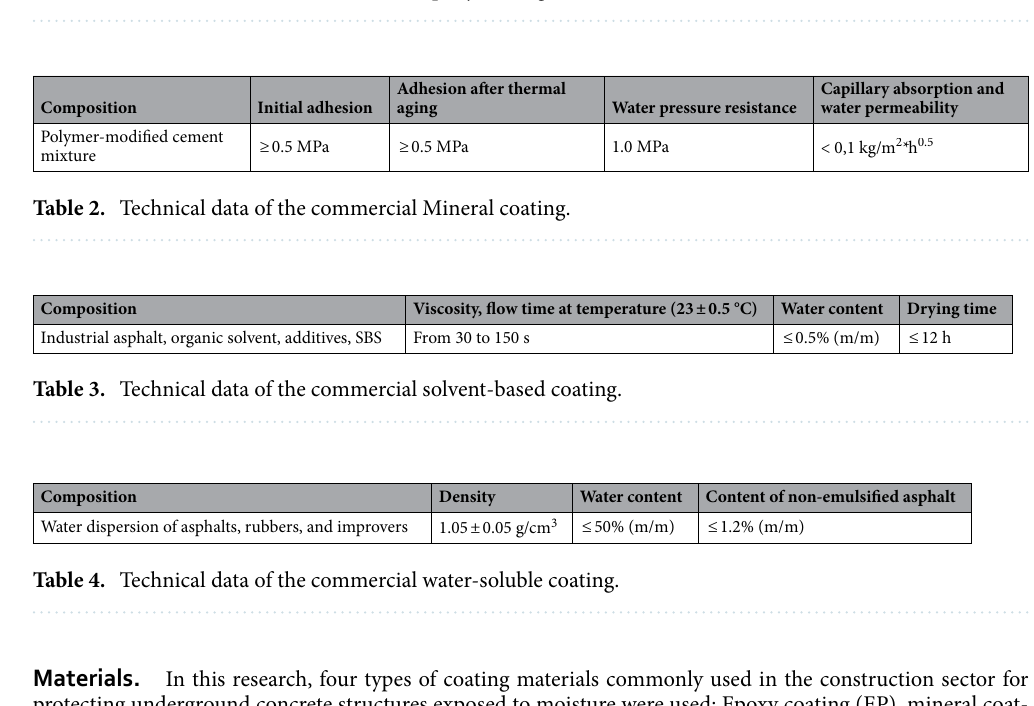
Table 1. Technical data of the commercial epoxy coating.